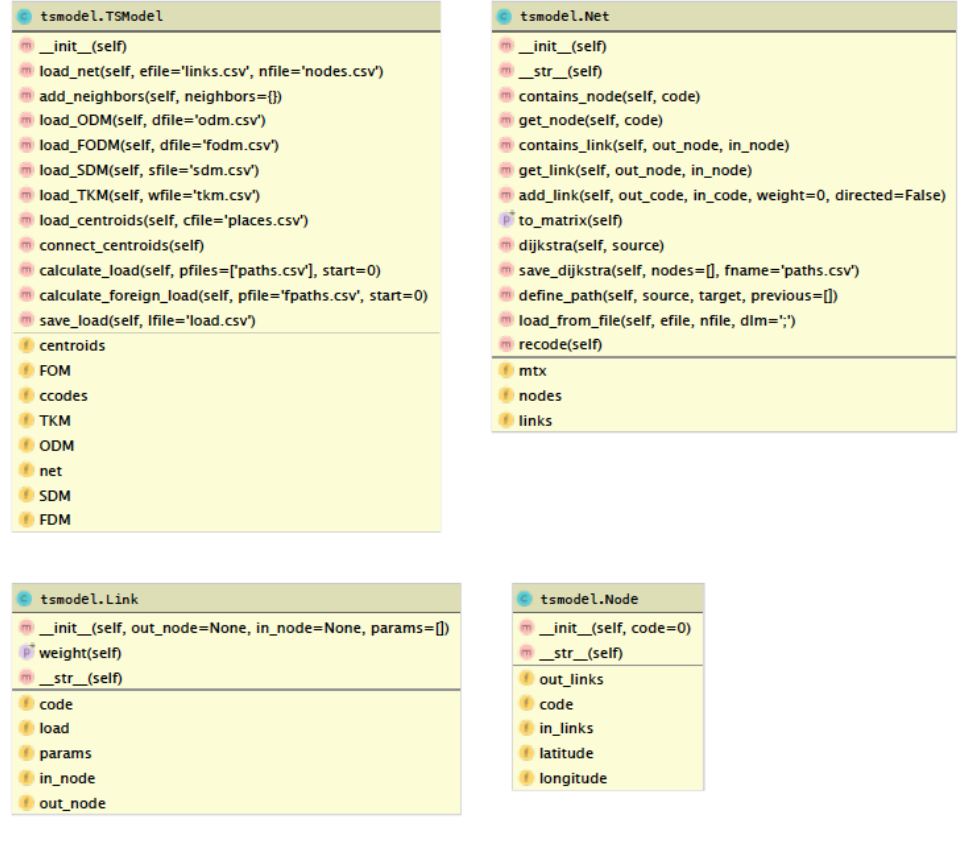
Figure 4. UML-diagram library for road transport system modeling.